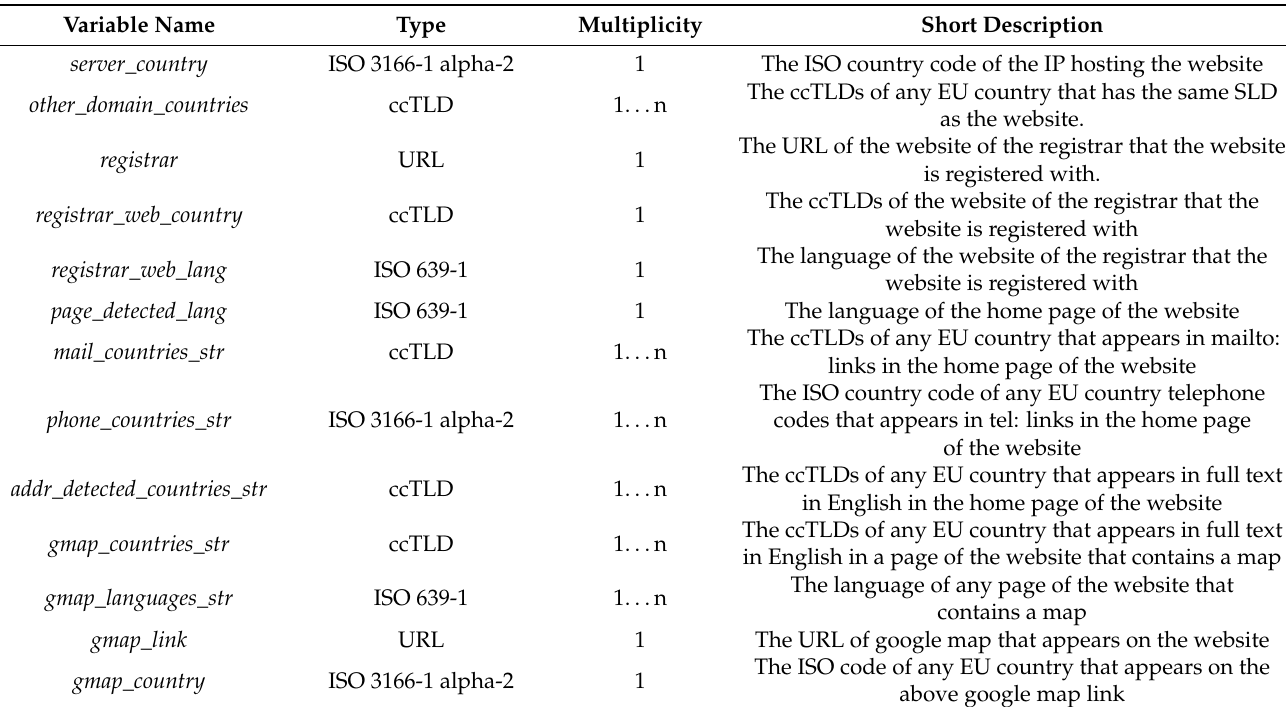
Table 1. Variables collected by the data extraction